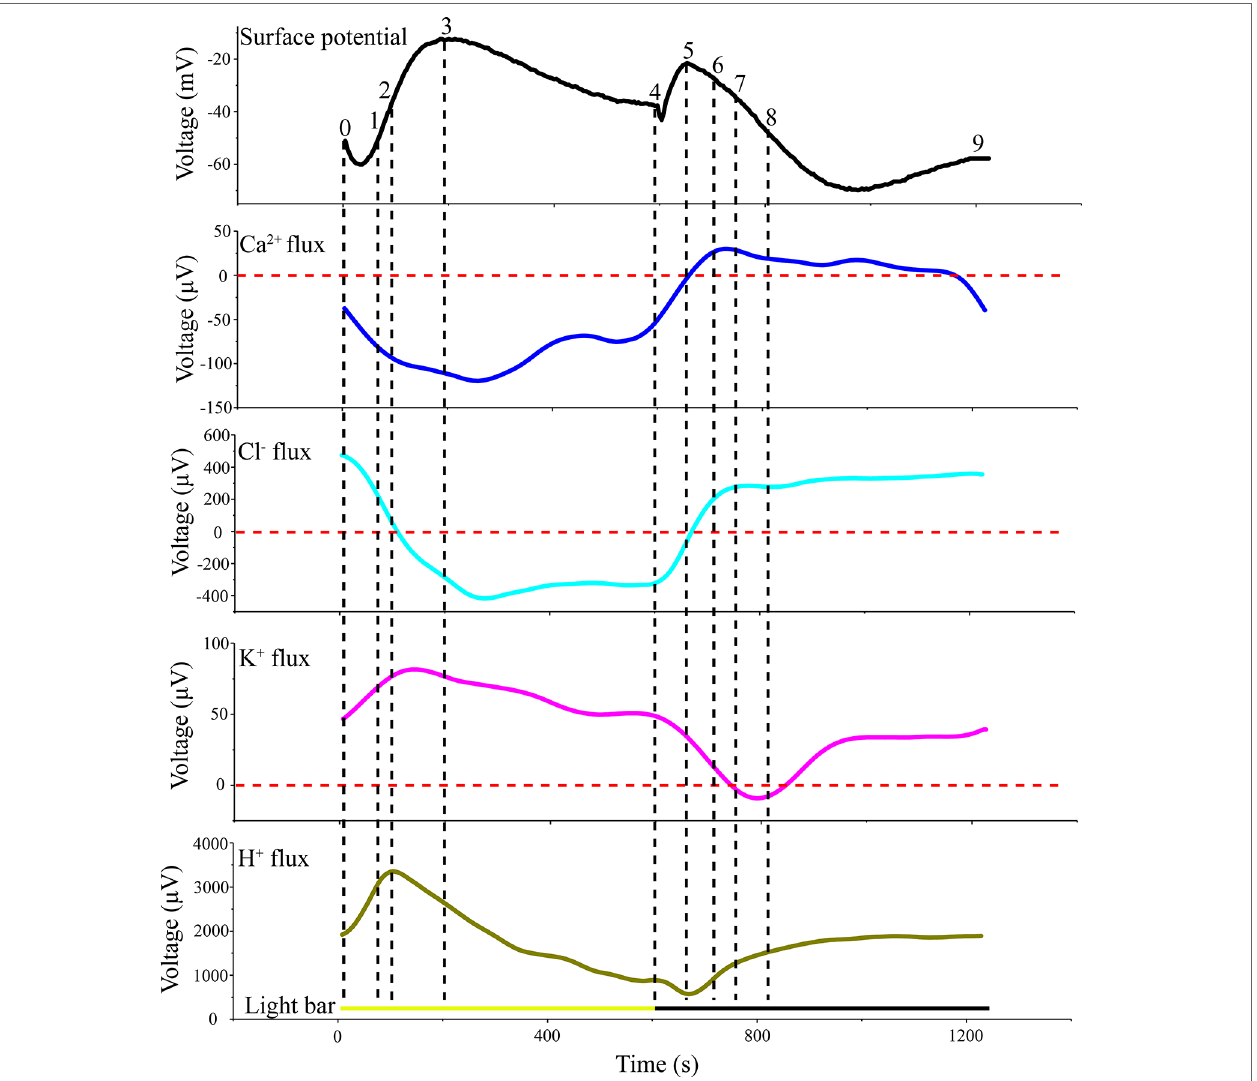
FIgURe 9 | Original voltage difference values of H + , Ca 2+ , K + , and Cl − and light-induced bioelectrogenesis in the same period. All ion fluxes were derived from the original value measured by SIET. The voltage difference values of the ion fluxes and surface potential were divided into nine segments (0–1; 1–2;…7–8; 8–9) by selecting crossing points (turning points) in each